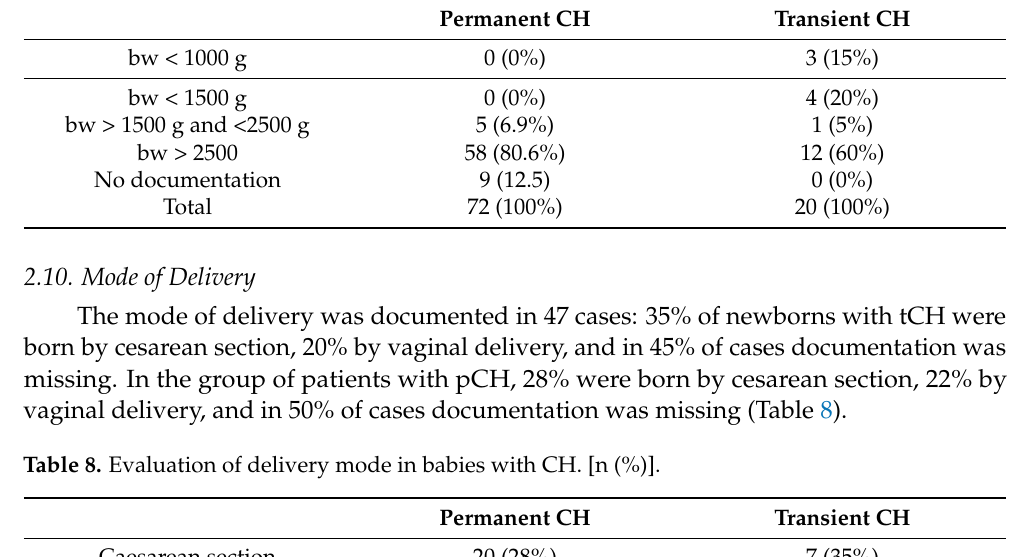
Table 7. Distribution of birth weight in babies with CH. [n (%)]. bw: birth weight. Permanent CH Transient CH